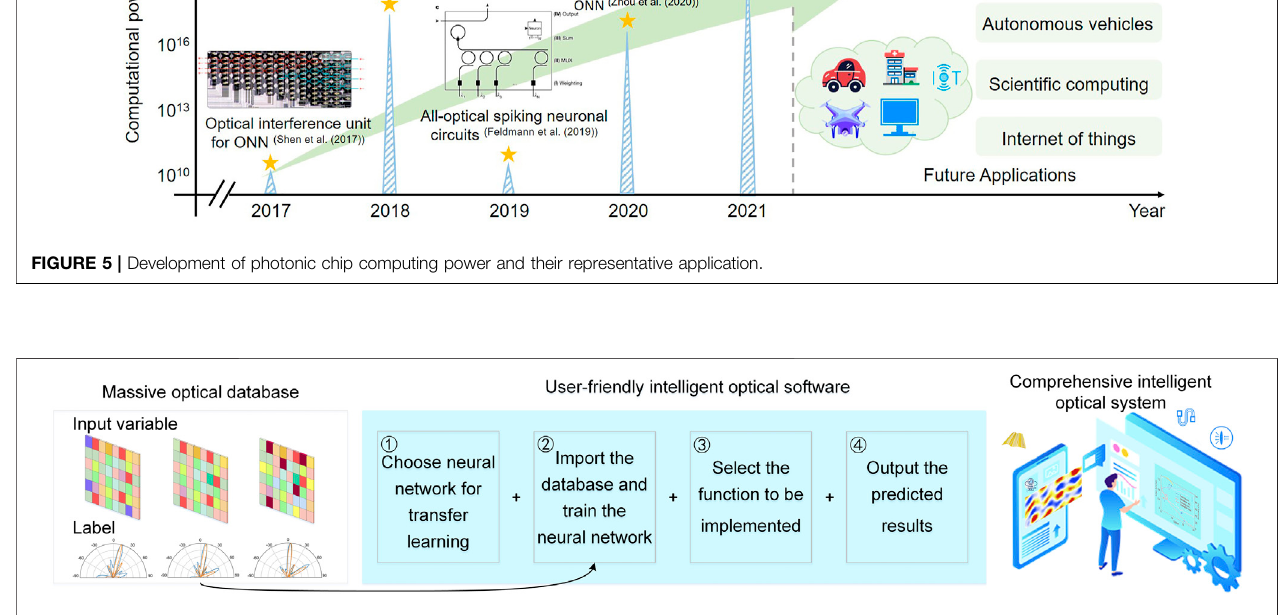
FIGURE 6 | An conceived user-friendly software system for photonic structure